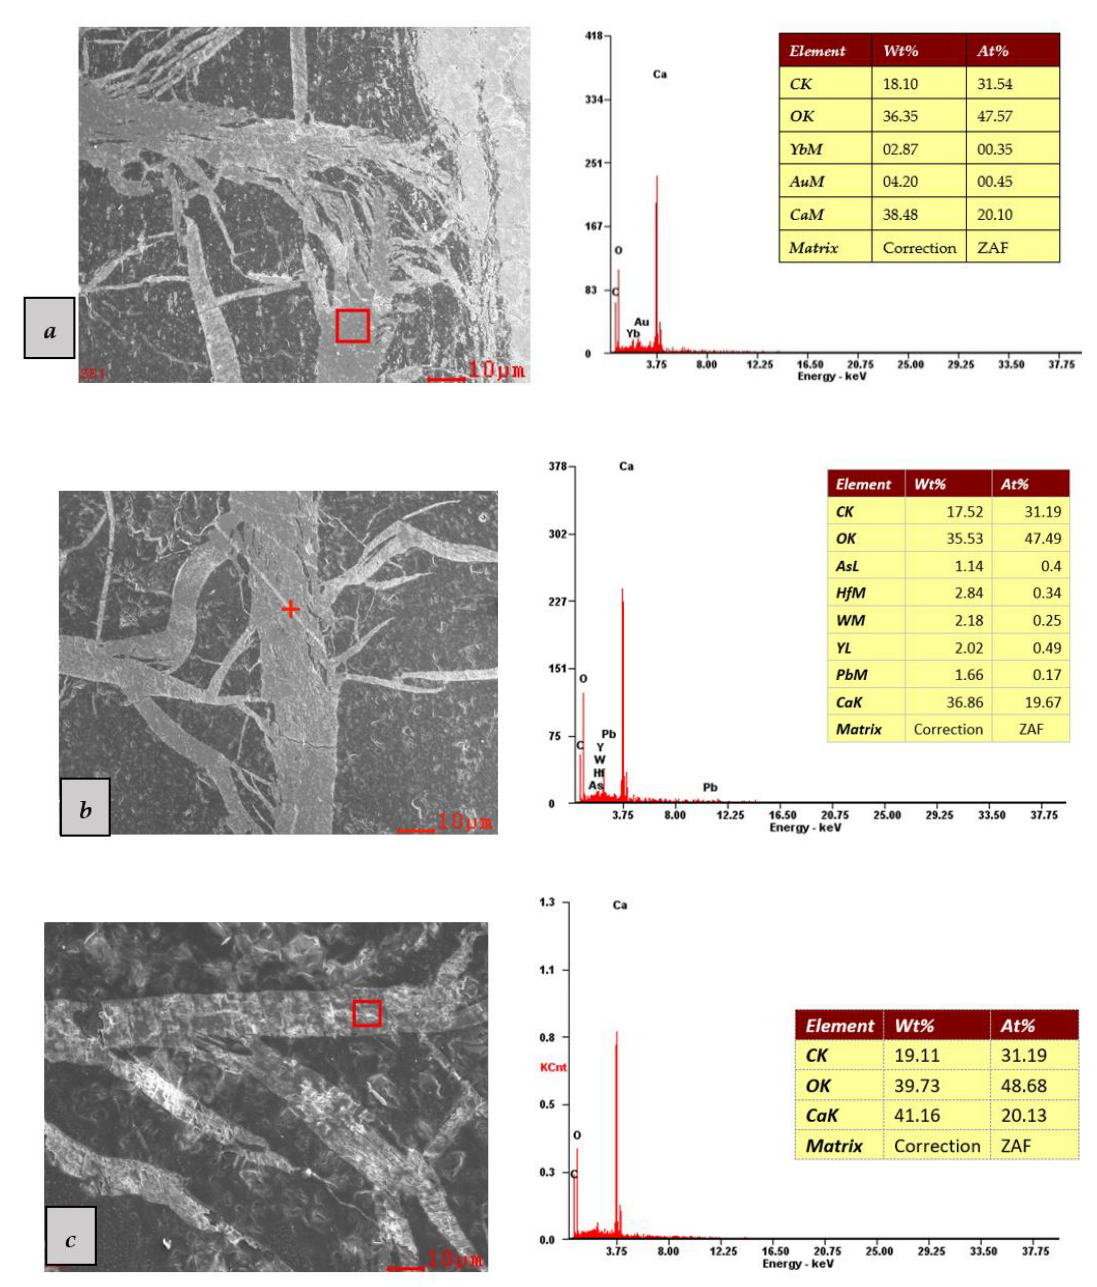
Figure 6. Results of SEM-EDS analysis of the infilling mineral matter (IMM) of the cleated structure coal from the Songhe coalmine, Liupanshui coalfield, Southwestern China. Note: Red crosses and red boxes in the picture are the detecting spots or areas of minerals. ( a ): Veined calcite with a ragged or twisted pattern; ( b ): Intersecting calcite vein; ( c ): Veined calcite with a root-like